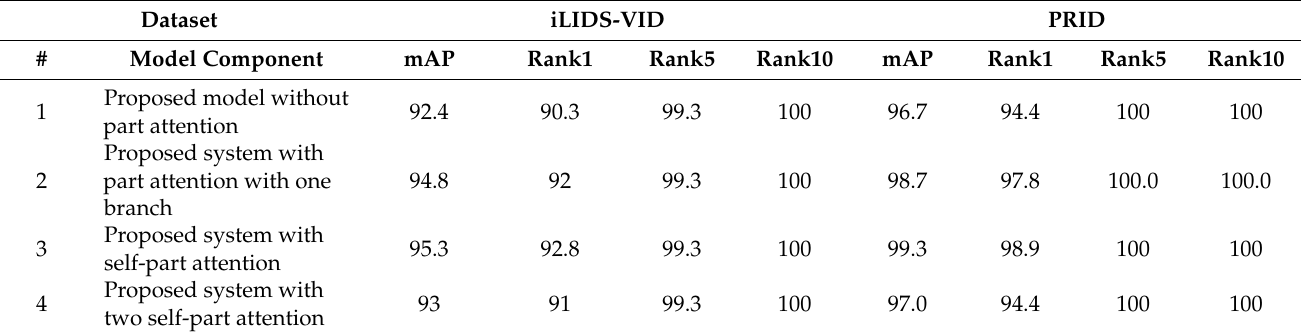
Figure 8. Part Attention with One Attention Branch. Table 9. The Effect of Self-Part Attention on the Coarse Branch. Table 9. The Effect of Self-Part Attention on the Coarse